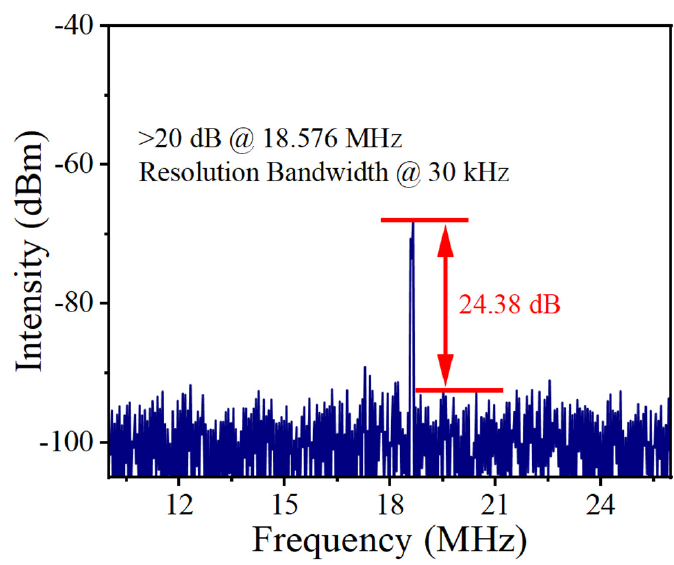
Figure 9. Mode-locked pulsed RF spectrum at 30 kHz resolution bandwidth.